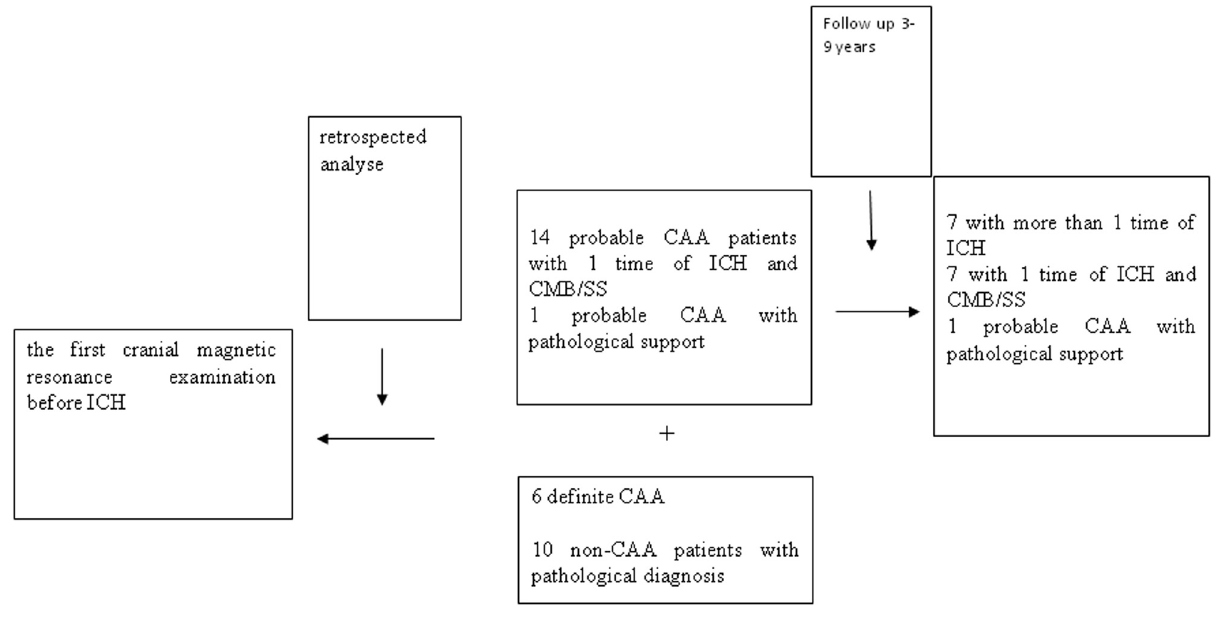
Figure 1: Flow diagram showing study enrollment and